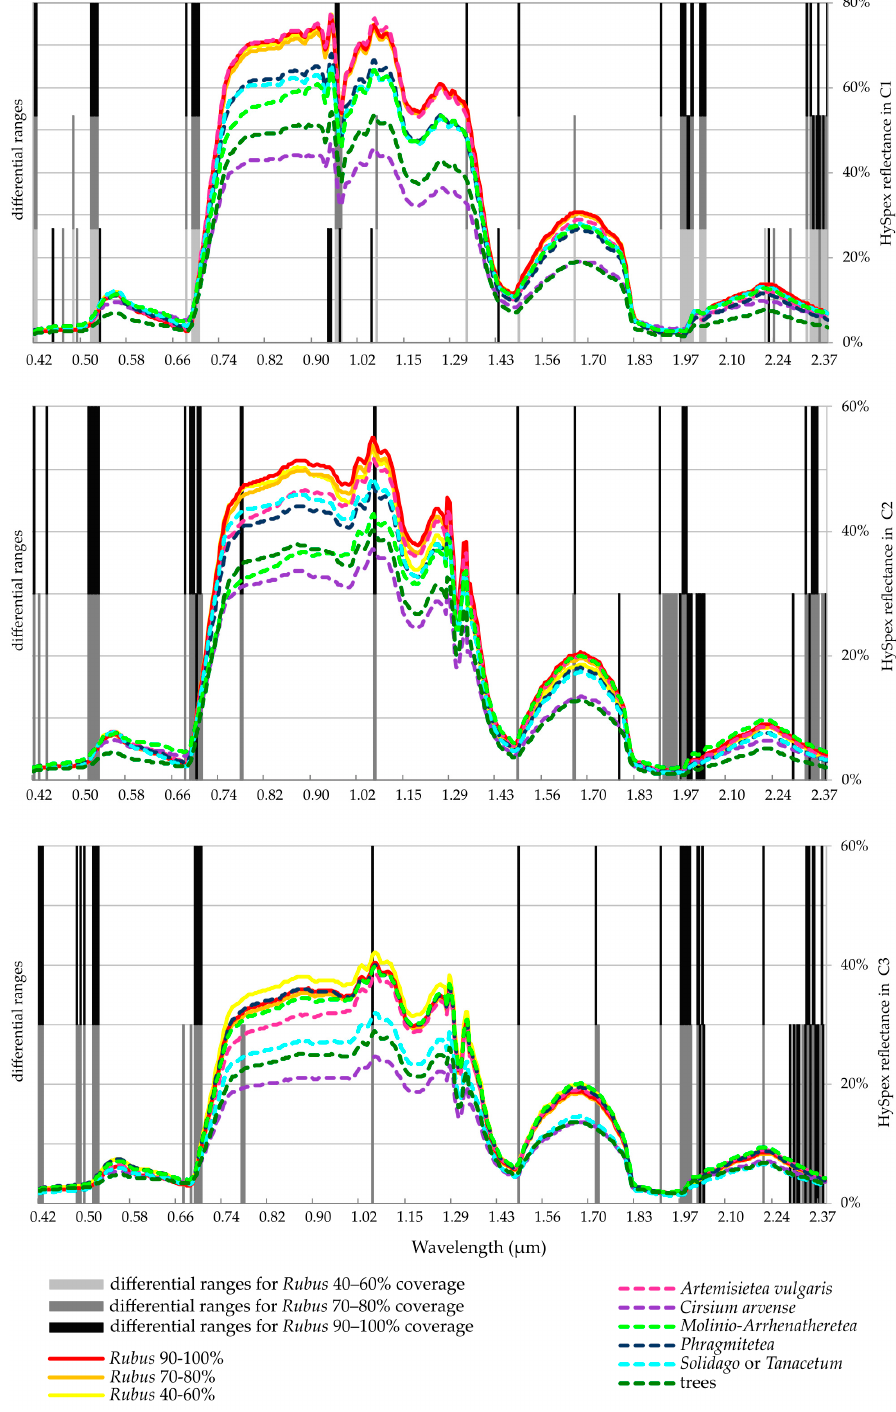
Figure 6. Average spectrum for different classes acquired from HySpex images and the bands (marked in dark grey, medium grey, and light grey dependent on Rubus coverage) that were defined as differentiating based on LDA analysis. The spectrum range was defined as differentiating when the frequency of the occurrence was above 15 (10% of 100 iterations).